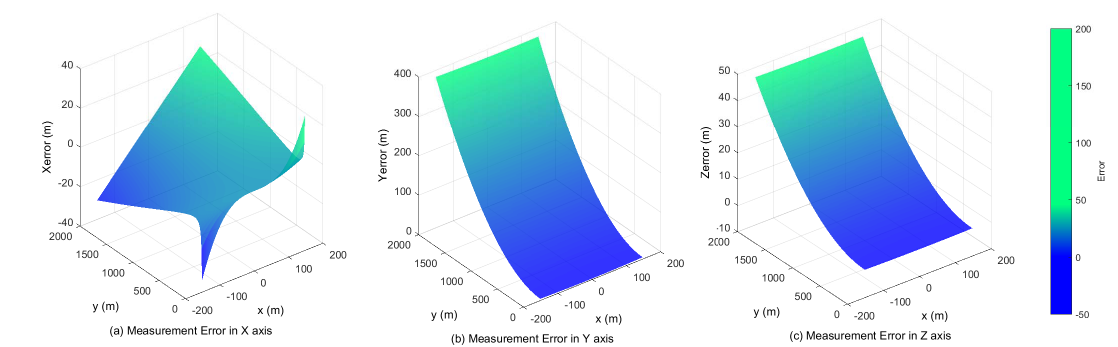
Figure 8. The baseline is 15 m, and the focus is 100 mm. The measurement errors in the X , Z and Y axis with 2000 m.